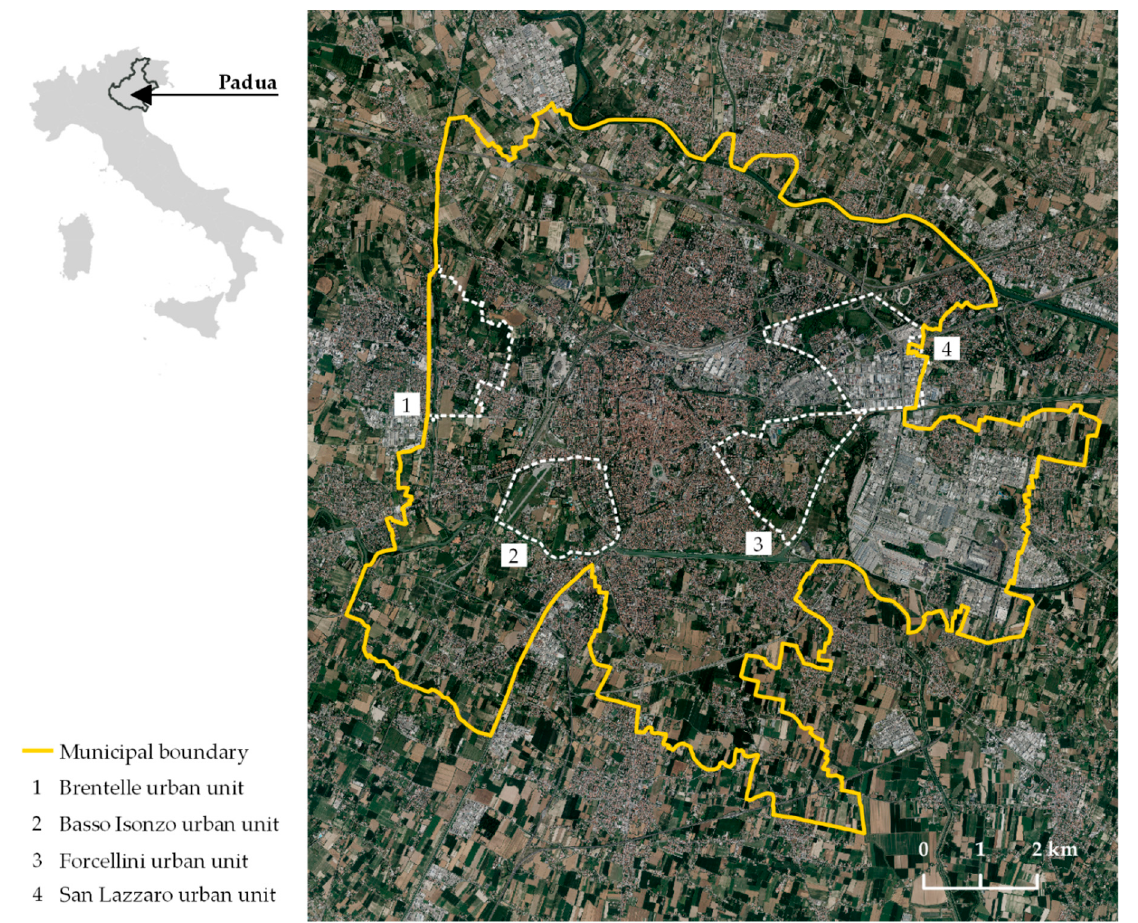
Figure 2. Location of the macro-sample areas within the municipality borders of Padua adopted as data validation.